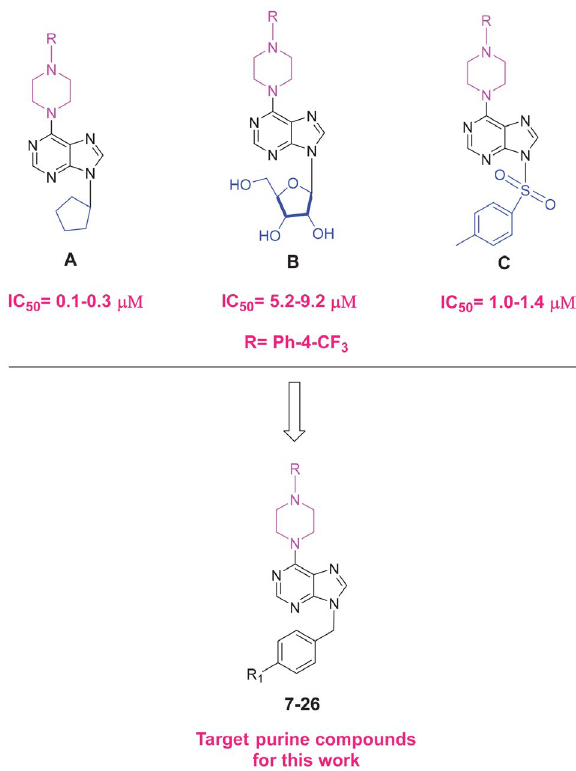
Figure 2. Structures of 9-(cyclopentyl/β-D-ribofuranosyl/ para -tol- uenesulfonyl)-6-(4-substituted piperazino)purine analogs A , B , C and target purine compounds 7 –